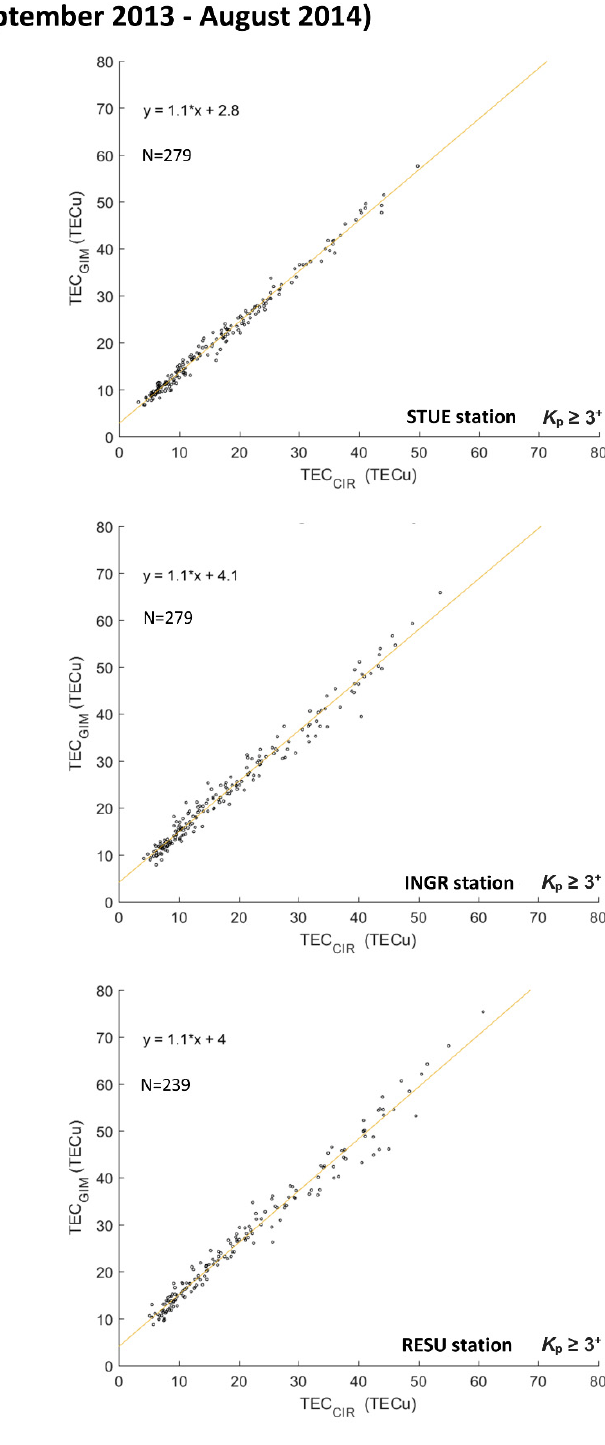
Figure 2. Scatterplots (TEC GIM vs. TEC CIR ) and corresponding linear regressions for STUE (upper row), INGR (middle row) and RESU (lower row) for the HSA period between September 2013 and August 2014. Left panels refer to quiet geomagnetic values ( K p < 3 + ), while right panels refer to disturbed geomagnetic values ( K p ≥ 3 + ). The number of considered measurements N is shown inside each plot.